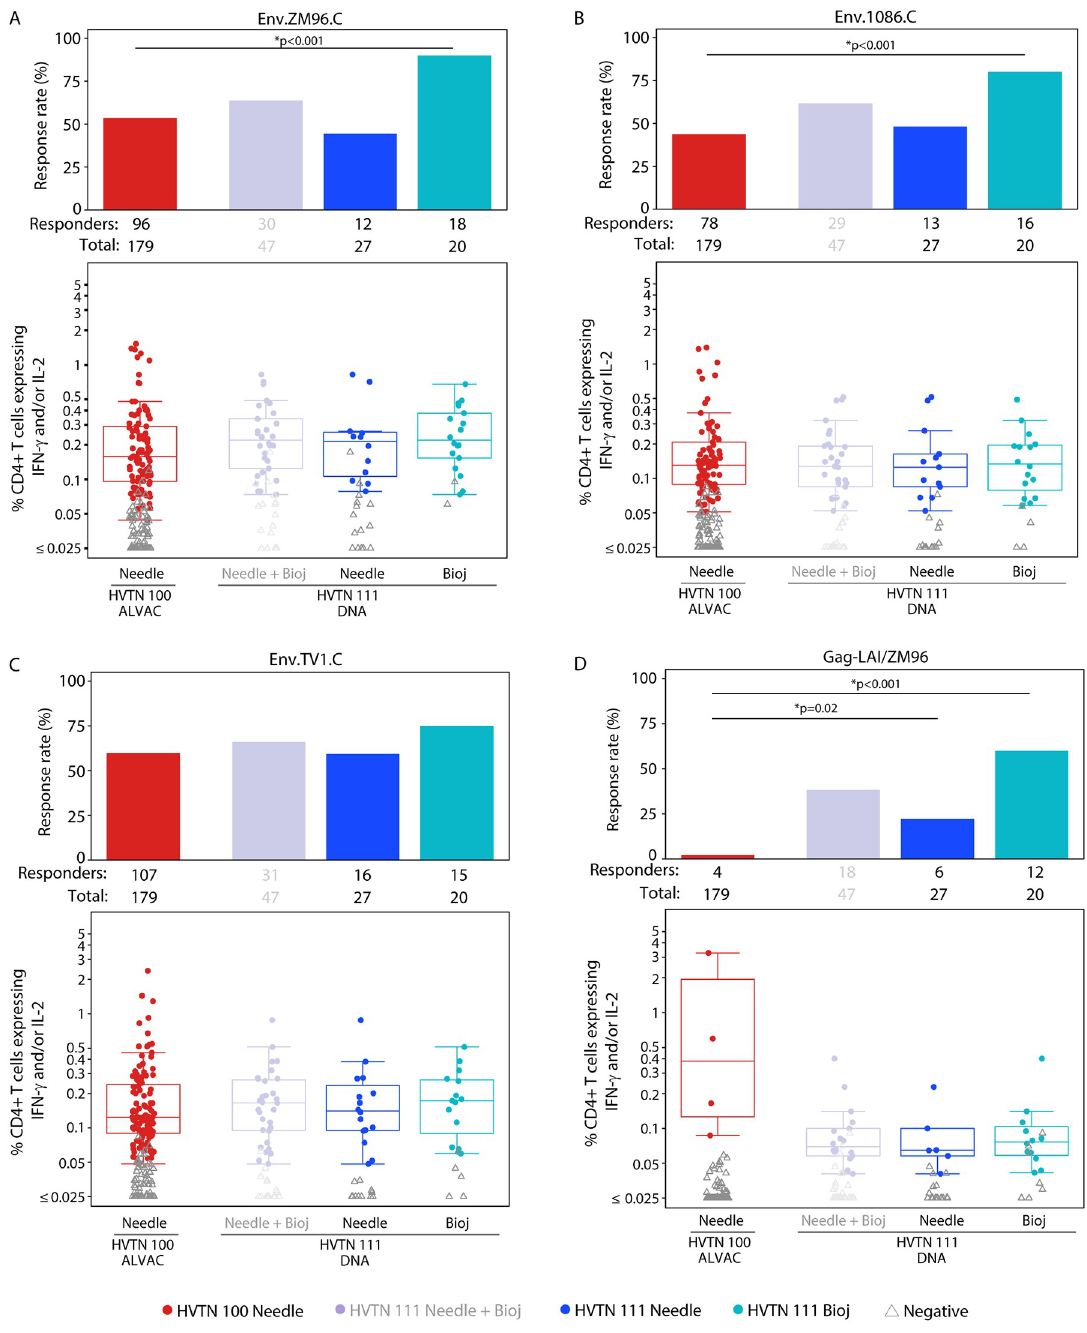
Fig 5. CD4 + T-cell responses to vaccine-matched antigens among per-protocol vaccine recipients at month 6.5. Bar charts show the observed, unadjusted positive response rates. Boxplots show observed responses and are based on positive responders only (shown as colored circles), negative responders are shown as grey triangles. � TMLE p -values reported; Barnard p -values < 0.011. HVTN 100 is compared to both the needle and Biojector arms of HVTN 111 (shown in blues) and is therefore not compared to combined arms of HVTN 111 (grayed out). Env, envelope; HVTN, HIV Vaccine Trials Network; IFN- γ , interferon gamma; IL-2, interleukin 2; TMLE, targeted minimum loss estimation.